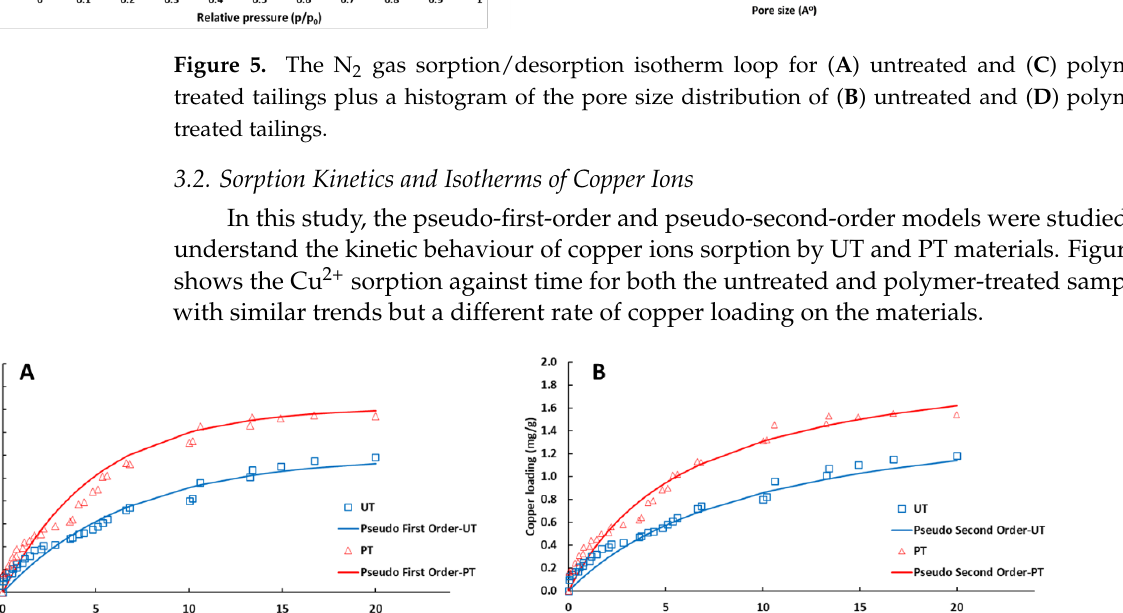
Figure 5. The N 2 gas sorption/desorption isotherm loop for ( A ) untreated and ( C ) polymer-treated tailings plus a histogram of the pore size distribution of ( B ) untreated and ( D ) polymer-treated tail- ings.